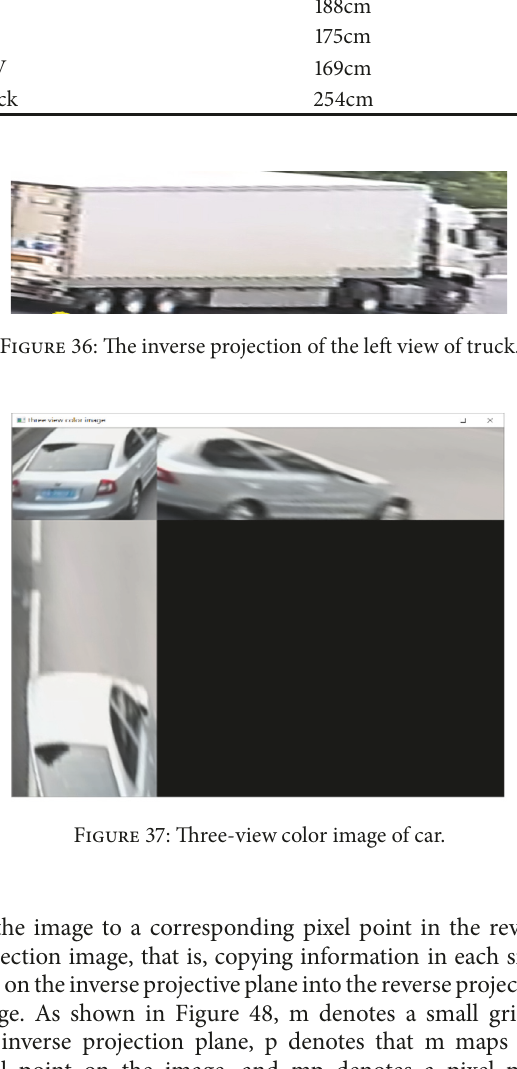
Figure 39: Extraction result of the line in the main view of van.